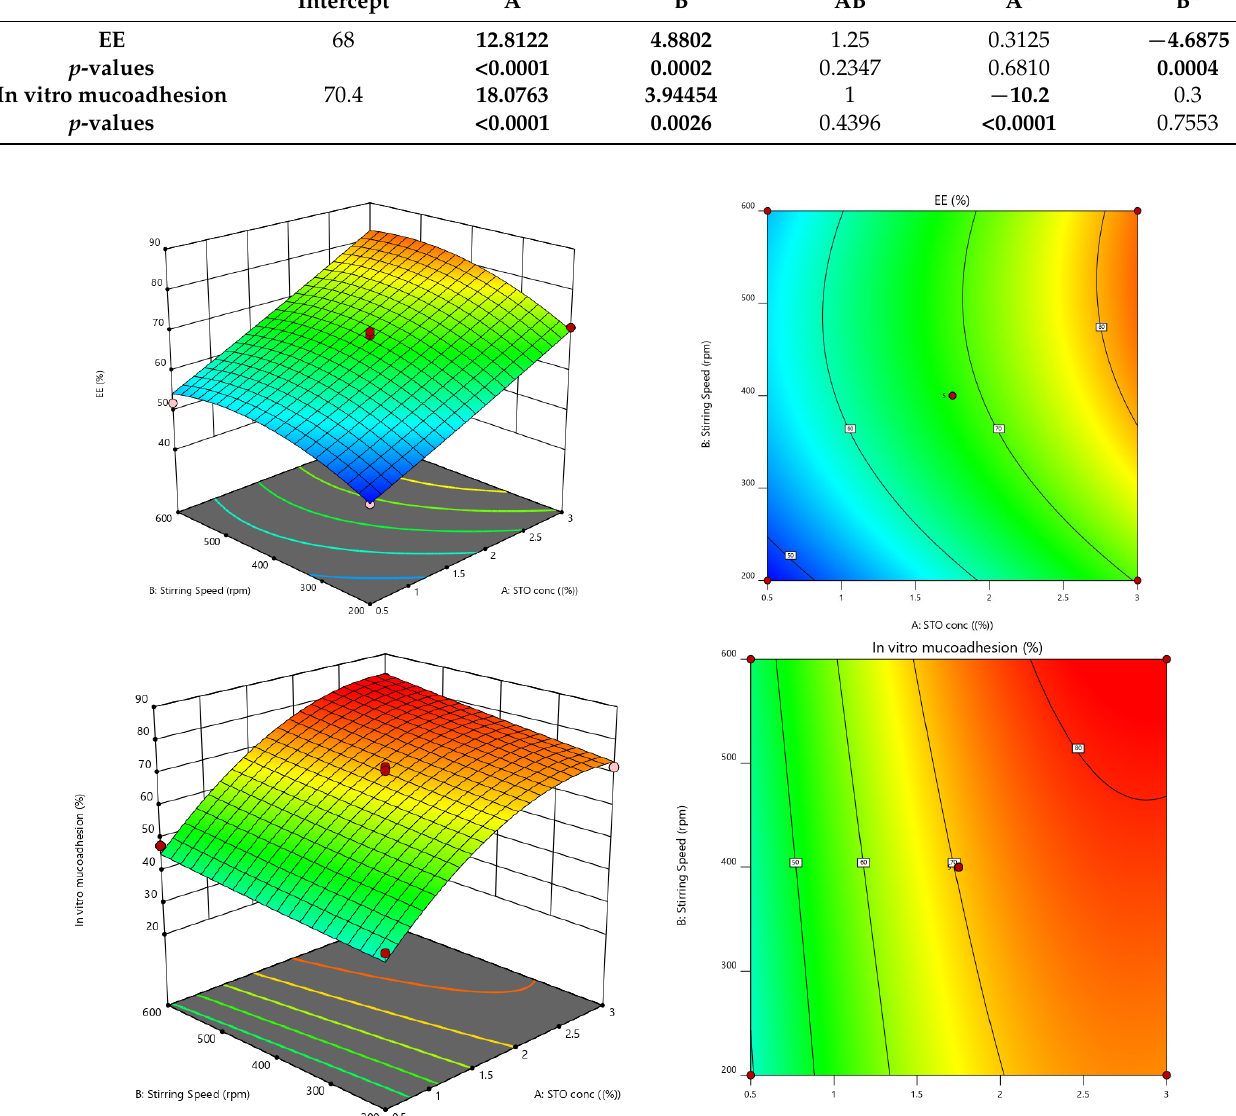
Figure 3. Response surface graphs for EE and in vitro mucoadhesion (3-dimensional and